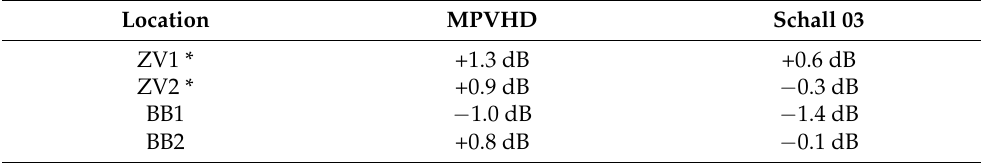
Table 6. Measurement and